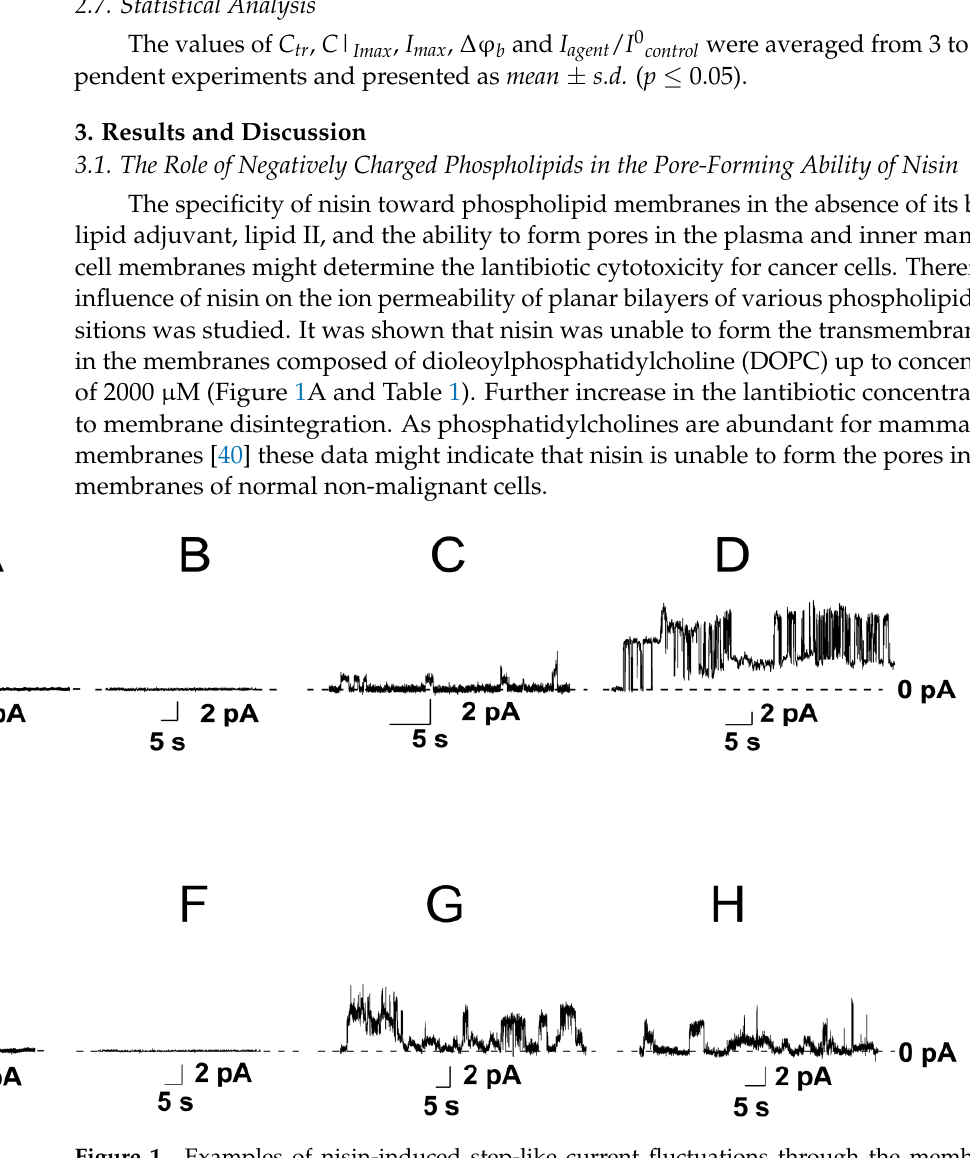
Figure 1. Examples of nisin-induced step-like current fluctuations through the membranes of different composition. The bilayers were composed of DOPC ( A ), DOPC/DOPS (50/50 mol%) ( B ), DOPC/DOPG (50/50 mol%) ( C ), DOPC/TOCL (50/50 mol%) ( D ), DOPE ( E ), DOPE/DOPS (50/50 mol%) ( F ), DOPE/DOPG (50/50 mol%) ( G ), and DOPE/TOCL (50/50 mol%) ( H ) and bathed in 0.1 M KCl, pH 7.4. The concentration of lantibiotics in bathing solution was equal to 2000 ( A ), 700 ( B ), 5 ( C ), 10 ( D ), 2000 ( E ), 600 ( F ), 60 ( G ), and 10 µ M ( H ). V = 100 mV. Table 1. The parameters characterizing the effects of nisin on the membrane of different phospho- lipid compositions. Lipid Composition